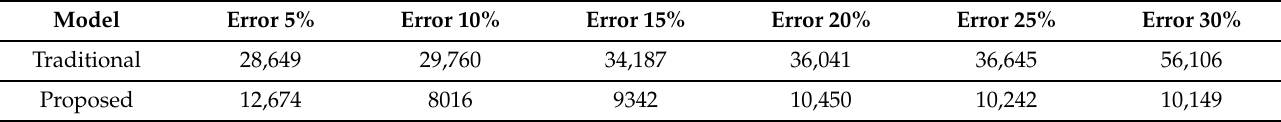
Table 3. Average validation error for two models with every tenth quality measurement retained and random missing output